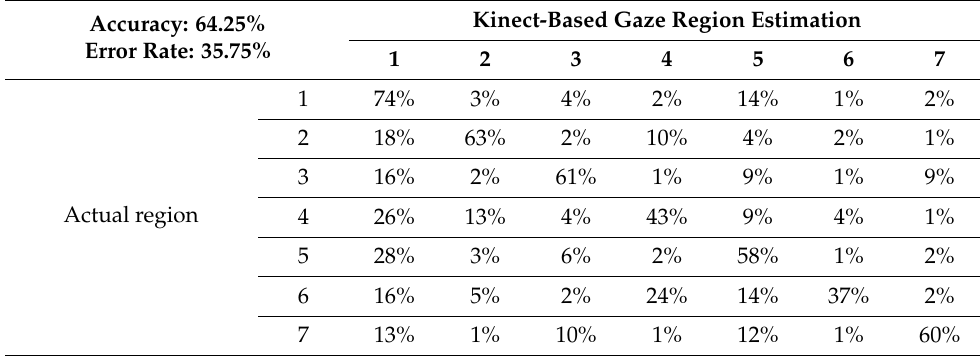
Table 5. Confusion matrix using method 4 (only two features: yaw and pitch) and Kinect. Accuracy: